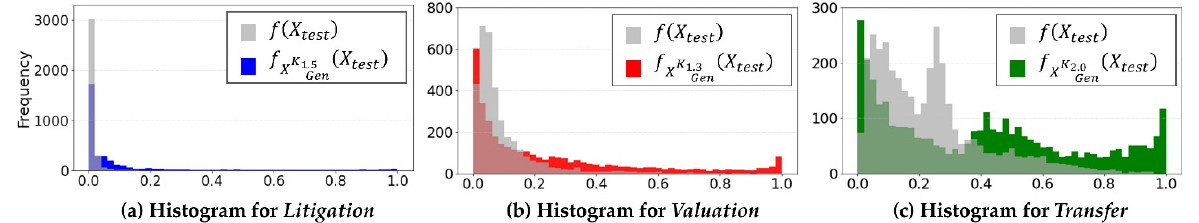
Figure 2. Distribution of the prediction probability for the target variables (when the generative model was C-VAE and the predictors were quantitative indicators and text of documents). ( a ) This figure shows the distribution of the prediction probabilities when the target variable was Litigation , which shows that the overall likelihood increased when the proposed method was used; ( b ) predicted distribution when the target variable was Valuation: this figure shows that the probability increases by 0.4 or more; ( c ) predicted distribution when the target variable is Transfer: it shows a similar pattern to the distribution in ( b ).